Question: What does this figure show? Answer in one sentence.
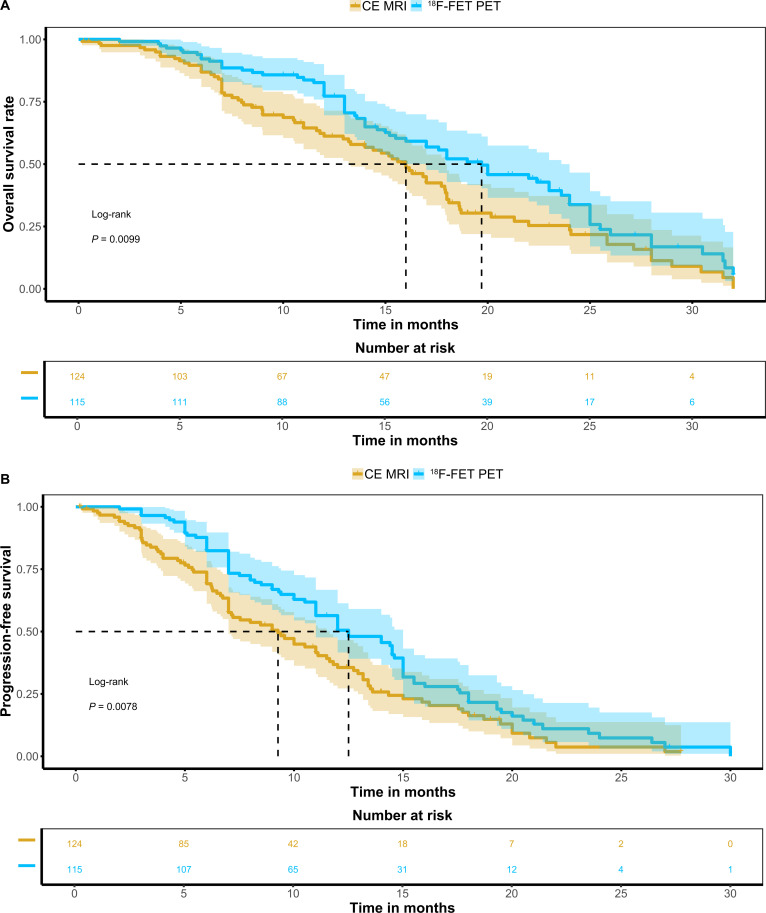
Answer: Kaplan–Meier (KM) survival analysis comparing the 18 F-fluoroethyltyrosine (FET) positron emission tomography (PET) and contrast-enhanced (CE) MRI groups. Shaded areas represent 95% confidence intervals (CIs). Numbers at risk at each time point are listed below the x-axis. (A) KM curve for overall survival (OS). The 18 F-FET PET group showed a significantly longer median OS of 19.7 months compared to 16.0 months in the MRI group ( P = 0.0099). (B) KM curve for progression-free survival (PFS). The 18 F-FET PET group had a significantly longer median PFS of 12.5 months, whereas the CE MRI group had a median PFS of 9.3 months ( P = 0.0078).